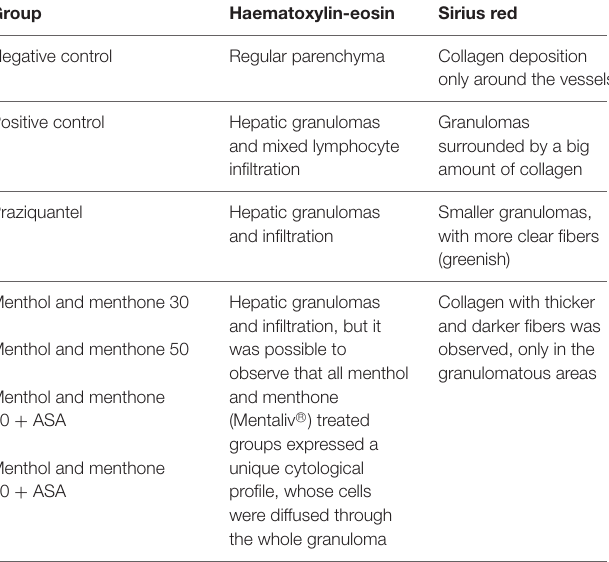
TABLE 3 | Histopathological